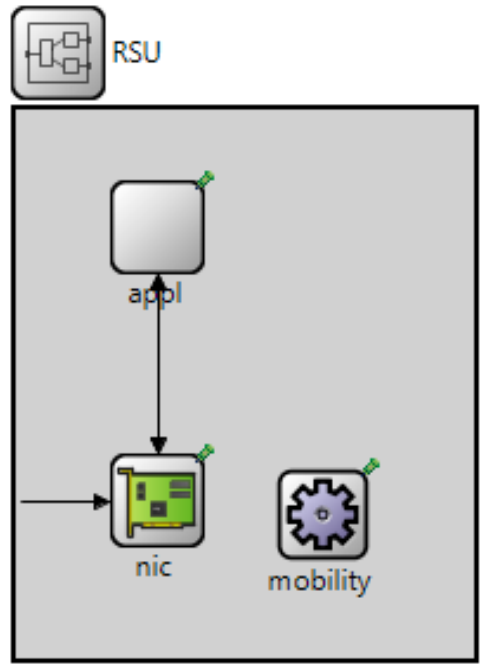
Figure 5. Roadside unit (RSU) model.